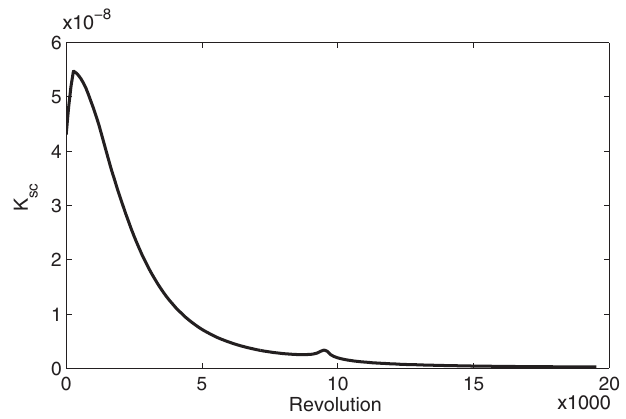
FIG. 5. (Color) Lattice functions (cid:3) , (cid:3) , D at the IPM location x z x normalized by the values at the first 1 ms, and the transition (cid:6) t (cid:5) 6 : 5 m , (cid:3) (cid:5) 20 : 5 m , D (cid:5) 1 : 8 m and (cid:6) where (cid:3) x 0 z 0 x 0 t 0